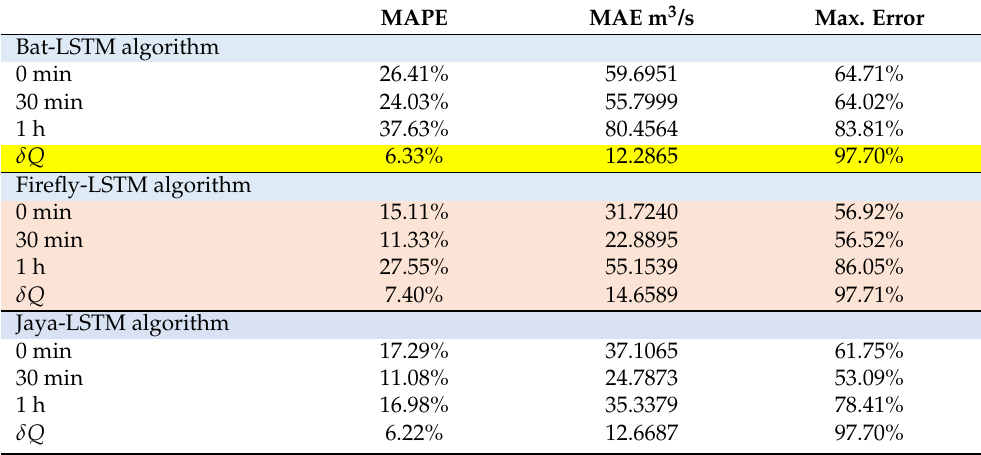
Table 6. Performance of LSTM-optimization algorithm models for streamflow forecasting. MAPE MAE m 3 /s Max.